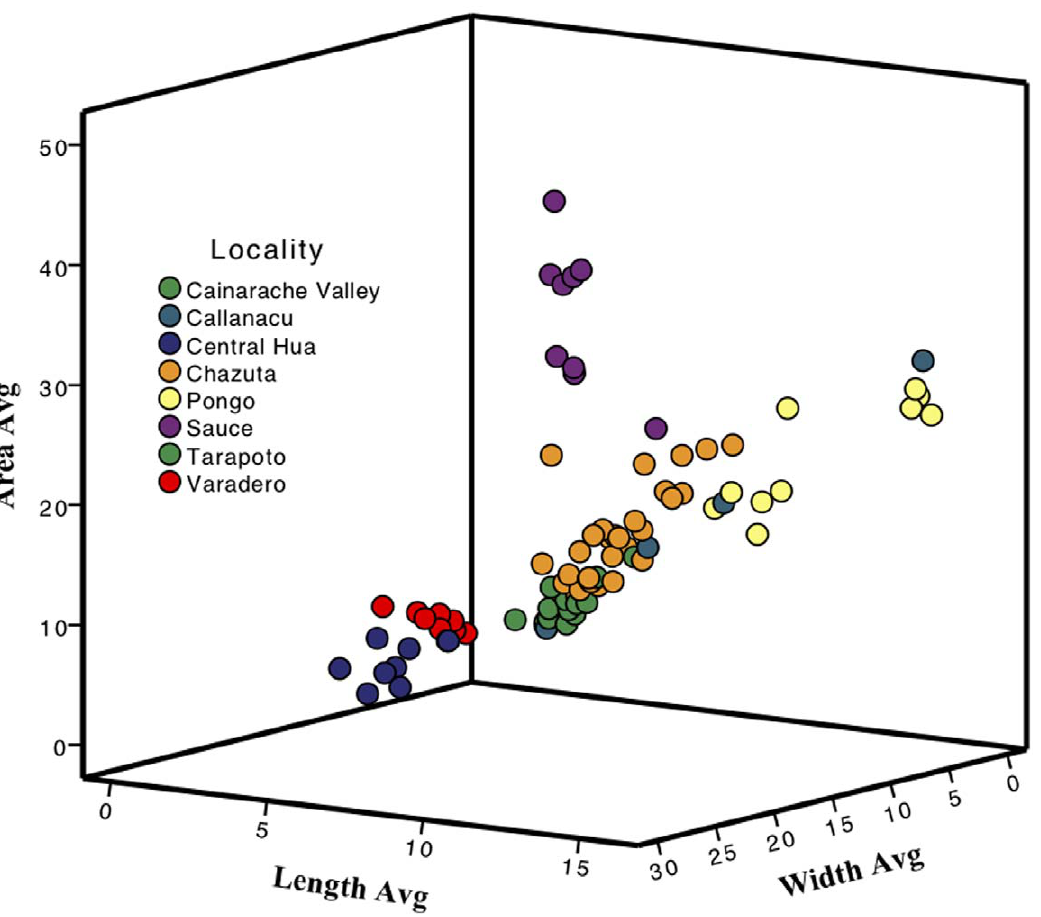
Figure 2. Visual representation of pattern divergence in length, width and area measurements. Populations of phenotypically similar morphs are grouped with matching colored dots.